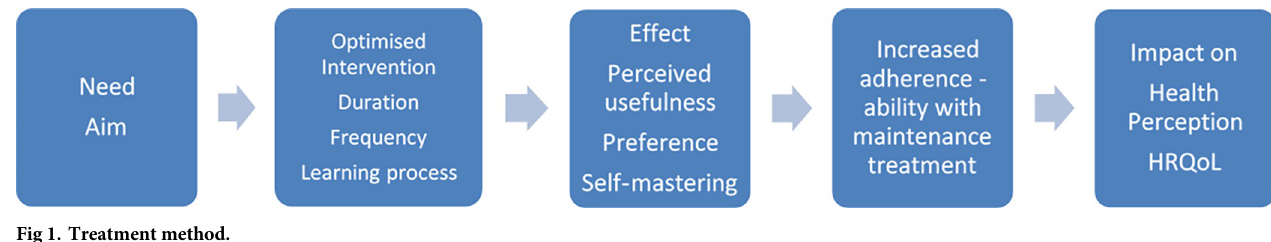
Fig 1. Treatment